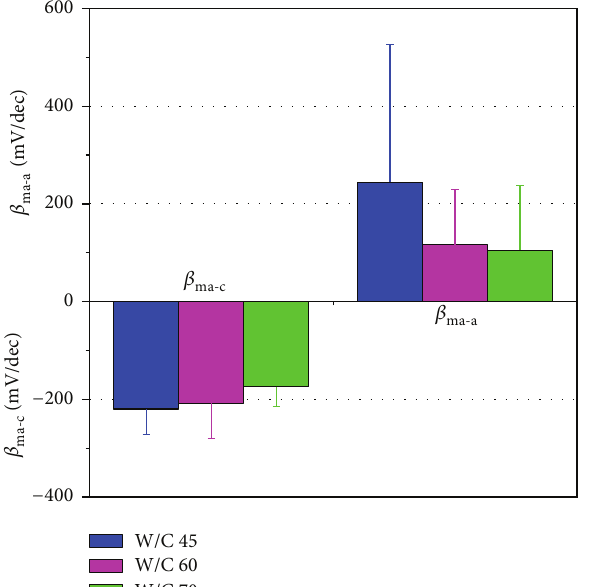
Figure 11: Effect of water/cement ratios on the macrocell polariza- tion slopes of cathode and anode.